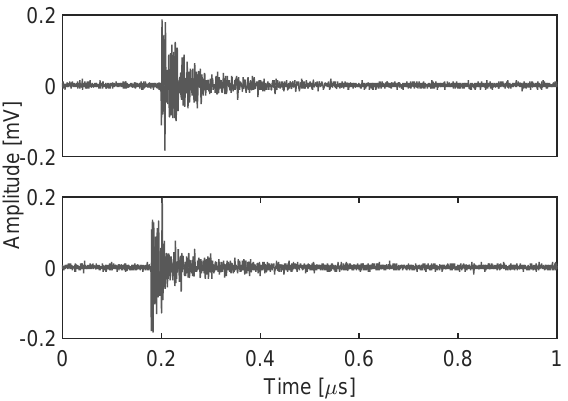
Figure 8. Simultaneous UHF signals from the same type of PD